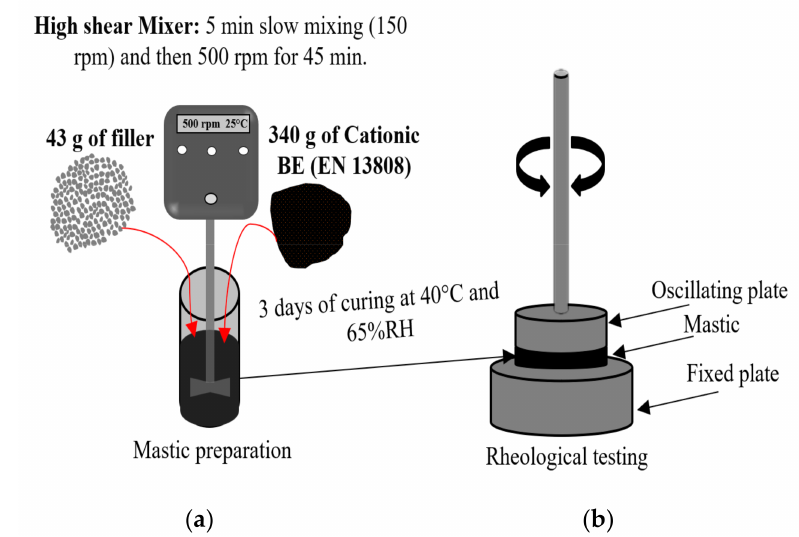
Figure 2. A schematic showing: ( a ) Mastic mixing and preparation; ( b ) Dynamic Shear Rheometer (DSR) rheological